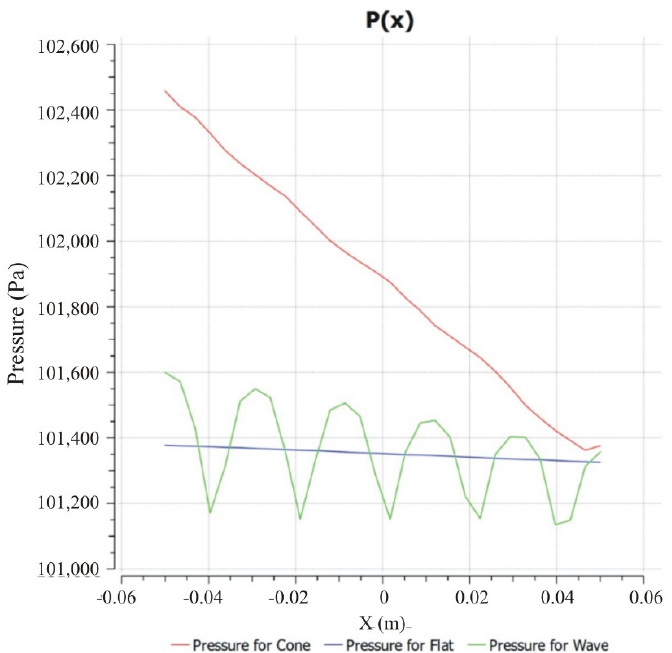
Figure 12. Graph showing pressure drop: red—plate with conical stamping; blue—flat heat exchange plate; green—chevron heat exchange plate.